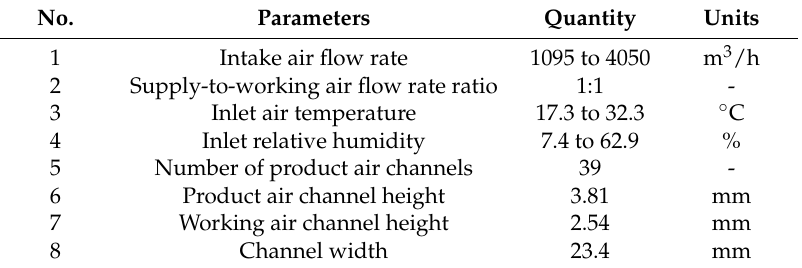
Table 3. Operating and geometric parameters for the experimental results of [22].